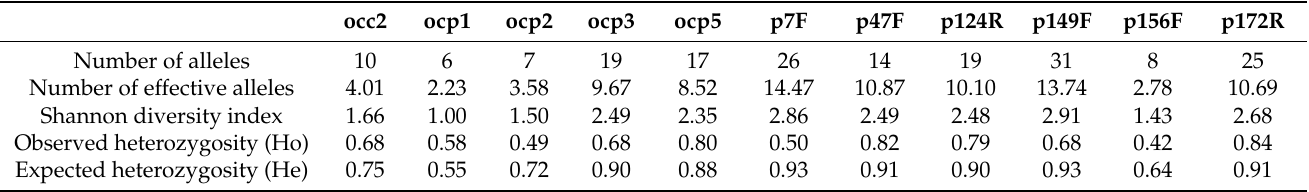
Figure 2. Distributions of the Queller and Goodnight genetic relatedness coefficients for social groups of ( a ) Dauria pikas and ( b ) Mongolian gerbils in Inner Mongolia, China. Table 1. Summaries of allelic diversity and heterozygosity for 11 microsatellite markers cross- amplified in Daurian pika, Inner Mongolia,